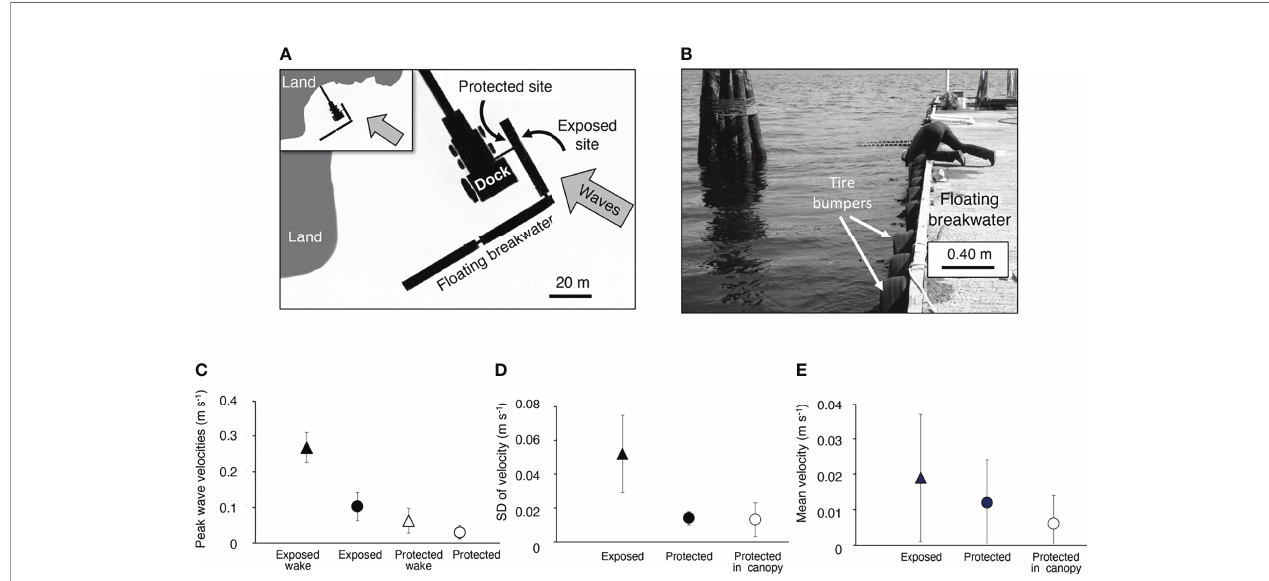
FIGURE 2 | Water fl ow measured at the protected and exposed study sites. (A) Map of the location of the exposed and protected sites on the fl oating breakwater at Friday Harbor Laboratories (inset shows a wider view of the area). Open water is to the right of the region shown in the maps. The direction of oncoming waves (both wind chop and ferry wakes) is indicated by the grey arrows. Measurements on a satellite image of the breakwater that maps the ferry paths (https://www. google.com/maps) show that ferries come within 450 to 530 meters of the breakwater. (B) Photograph of the tire bumpers along the exposed side on the fl oating breakwater, which is 5 m wide. (C) Peak fl ow velocities measured at a depth of 20 cm below the air-water interface at positions just upstream from or within M. splendens canopies on different tires. The mean of the peaks of each fl ow record (1 minute duration, except for the case of the ferry wakes, which lasted about 10 to 15 s) were calculated. The grand mean of all the replicate measurements is plotted (number of replicate measurements, n, at different locations along the dock for each condition are: exposed site, n = 10; exposed site in ferry wake, n = 3; protected site, n = 10; protected site in ferry wake, n = 2; protected site within the algal canopy, n = 2). The peak velocities on the exposed side of the dock were signi fi cantly higher than those on the protected side of the dock (p < 0.01), and the peak velocities in the ferry wakes hitting the exposed side of the dock were signi fi cantly higher than all the other fl ow conditions (p < 0.01) (one-way ANOVA followed by Tukey HSD test, F = 21 4,24 ). (D) Variation in fl ow velocities measured during 1-minute fl ow records as described in (A) Because ferry wake records were shorter, they were not included in this analysis. Fluctuations, represented by the standard deviation of the velocities measured at each location, were due to turbulence